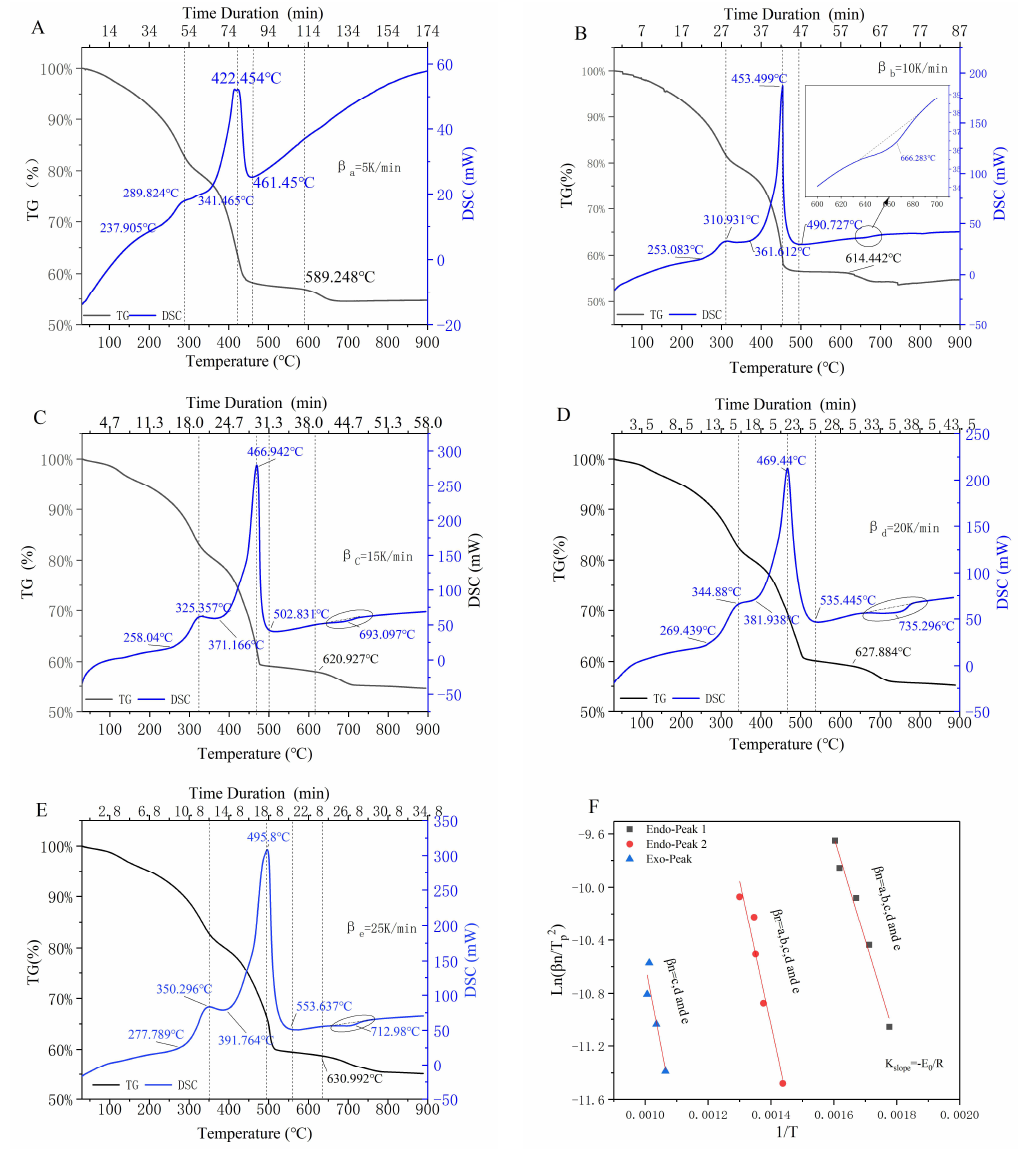
Figure 1. The DSC/TGA analysis of upstream oily sludge at β n ( n = a, b, c, d, and e); β a = 5 K/min ( A ), β b = 10 K/min ( B ), β c = 15 K/min ( C ), β c = 20 K/min ( D ) and β d = 25 K/min ( E ), endothermic/exothermic peak analysis ( F